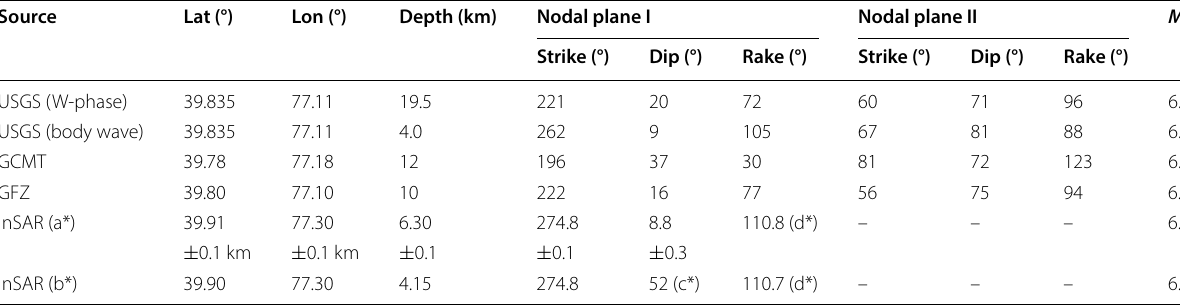
a* represents the planar fault model, b* represents the listric fault model and its dip angle, c* is the dip of the ramp segment, the dip of the flat segment is fixed to be 2°, d* is the mean rake of each patch InSAR coseismic deformation